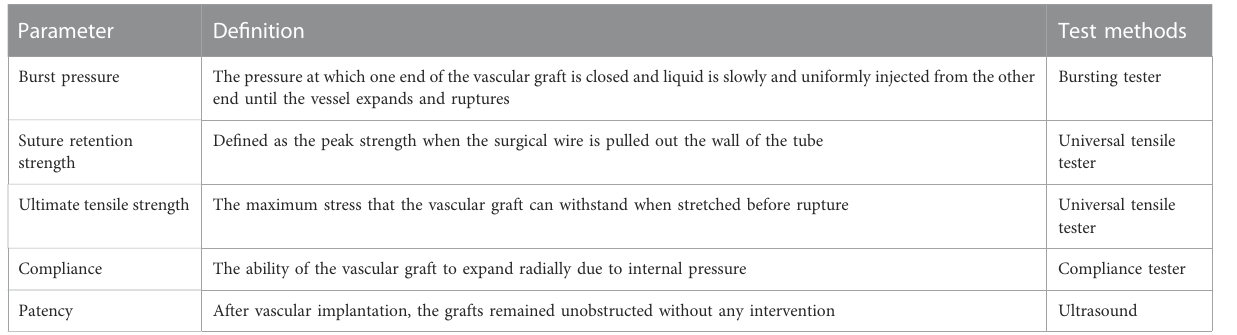
TABLE 1 Relevant parameters for the properties of vascular